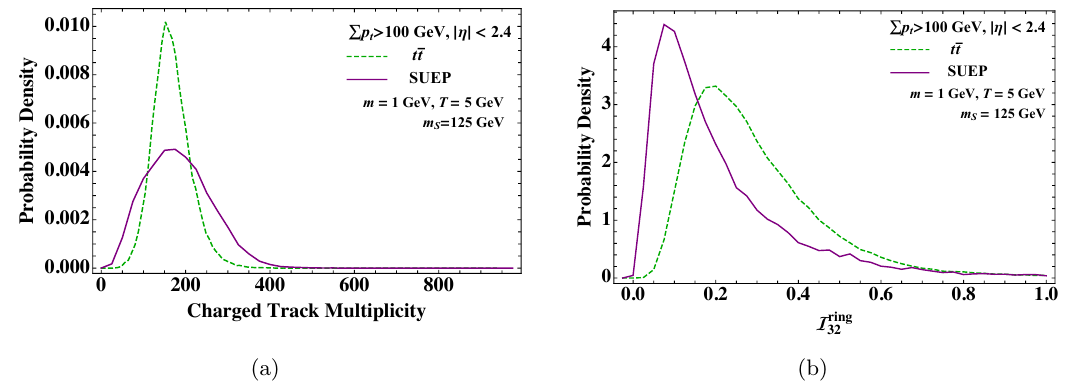
Figure 23 . The same observables as (cid:12)gure 21 but comparing the t (cid:22) t sample (green) to the m = 1 GeV, T = 5 GeV SUEP sample (purple). The distributions of charged track multiplicity cover a similar range for both samples, but the peaks in ring-like event isotropy are better separated.